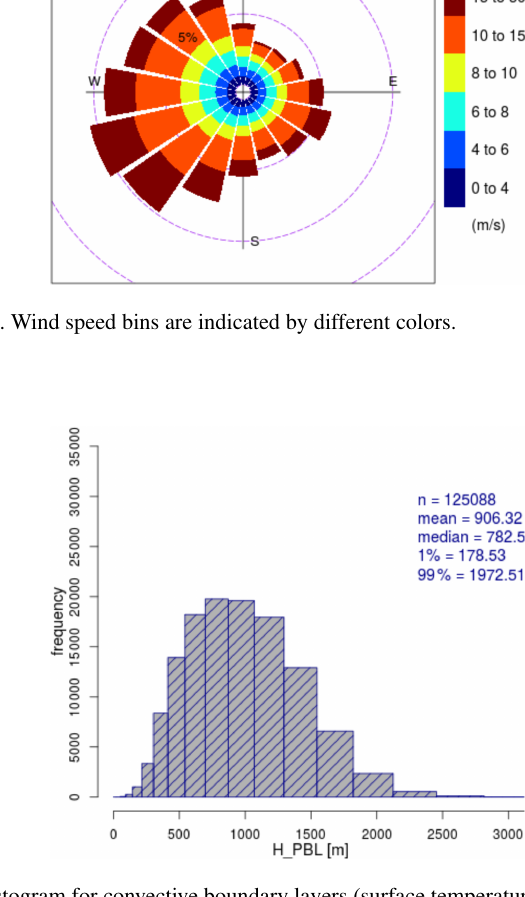
Wind Energ. Sci., 7, 715–739, 2022